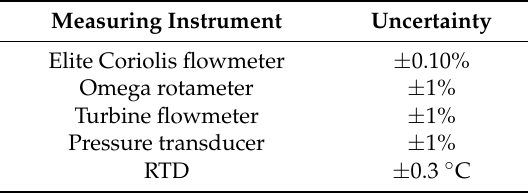
Table 3. Uncertainties reported by the instruments’